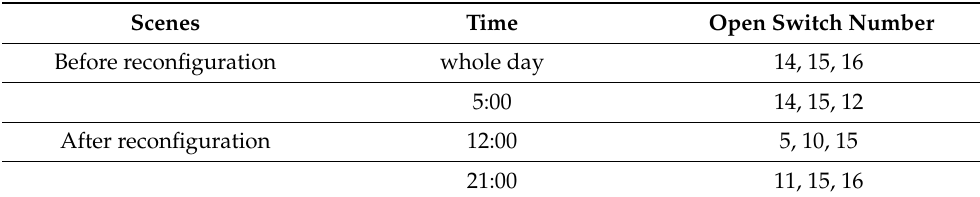
Table 2. Switch action before and after reconstruction.